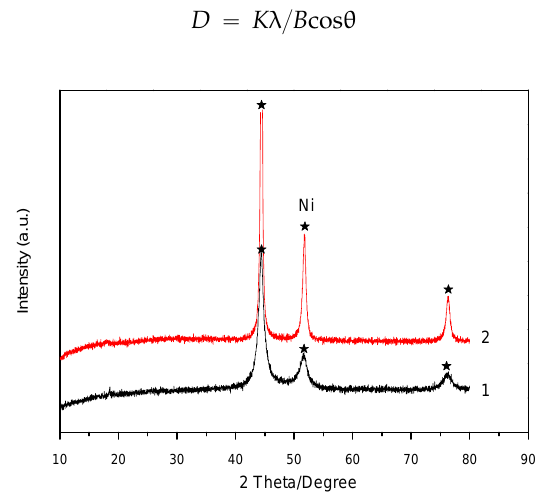
Figure 1. X ‐ ray diffraction (XRD) patterns of ( 1 ) fresh Raney Ni; ( 2 ) Raney Ni used in Table 1, Entry 6.